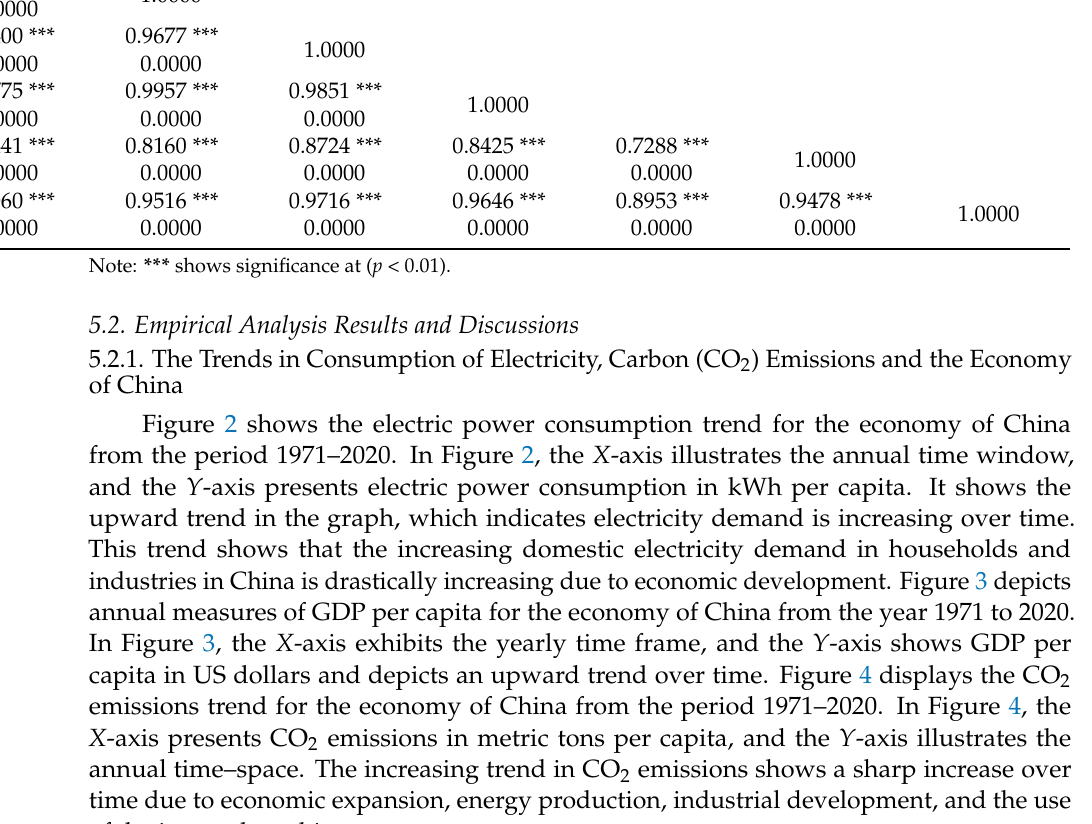
Figure 3. The GDP per capita trend for the economy of China for the period 1971–2020. Figure 4. The CO 2 emissions trend for the economy of China for the period 1971–2020. 5.2.2. The Decoupling Analysis (DA) of Consumption of Electricity and the Economy of China Here we have explored the linkage between the consumption of electricity and eco- nomic growth with a decoupling states comparison. Table 4 and Figure 5 present six types of decoupling states: strong decoupling, weak decoupling, expansive coupling, strong negative decoupling, expansive negative decoupling, and recessive coupling. The econ- omy of China has seen a 2318.828 annual upsurge in the data window, and electricity consumption has also increased In line with the passage of this time frame. The economy of China from the period 1971 to 2020 experienced weak and expansive negative decou- pling in large numbers. These results show that weak decoupling happens when there is